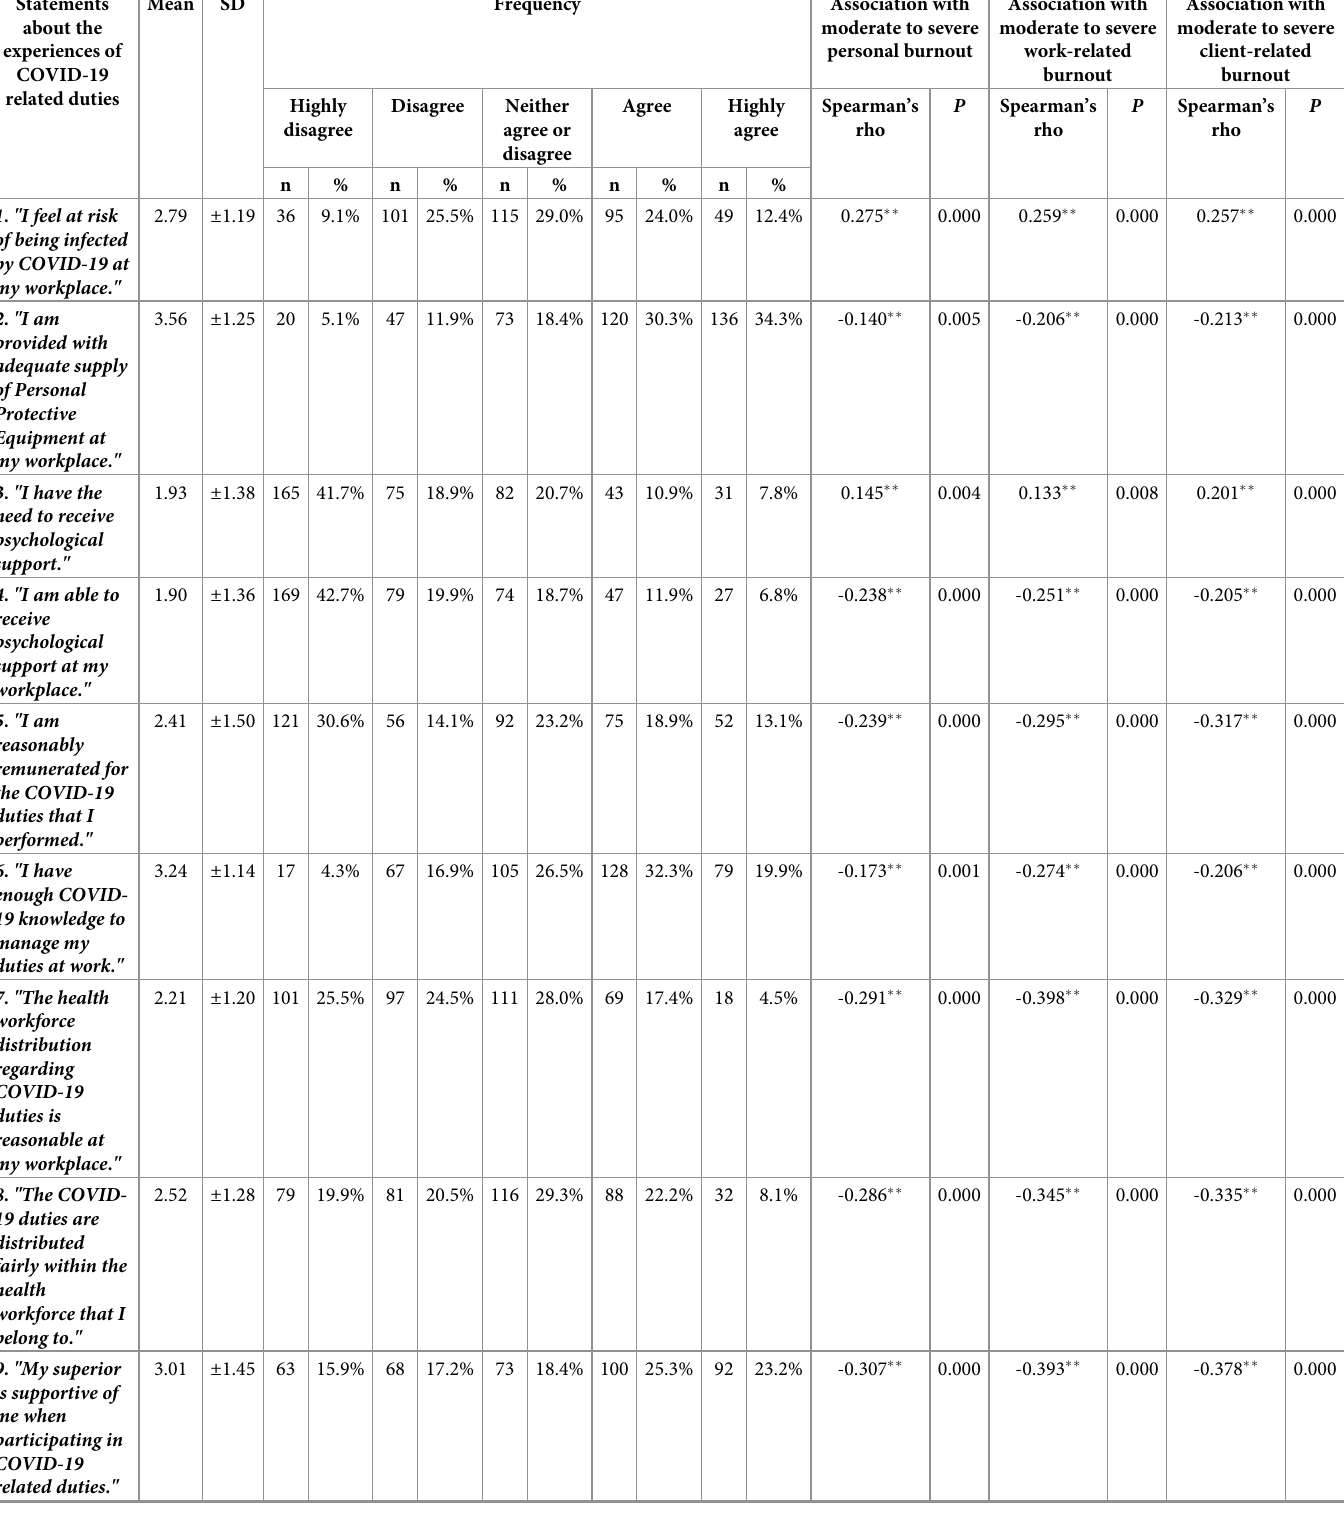
Table 6. Respondents’ experiences with COVID-19 related duties and the association with burnout (n =